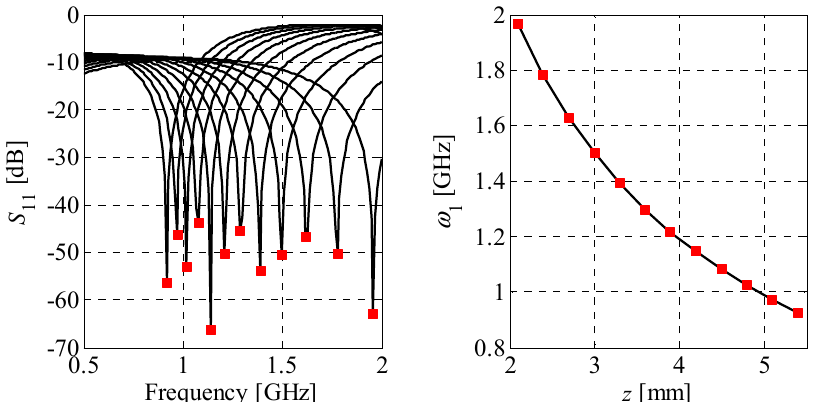
Figure 7. Family of CC characteristics (left-hand side) obtained for an arbitrarily selected line segment z in the search space and their corresponding feature-based response (right-hand side) defined w.r.t. level (here, minimum of S 11 in frequency).